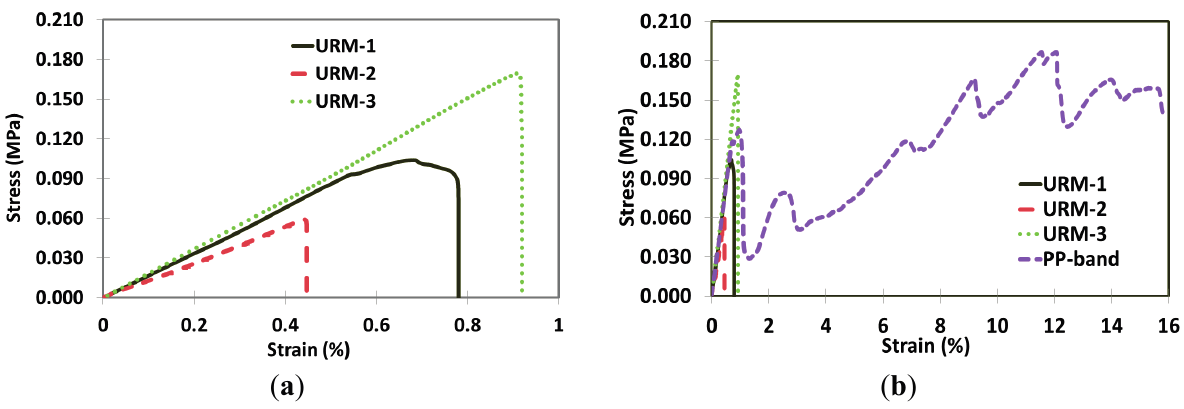
Figure 1. Stress-strain curves of masonry panels under diagonal compression test, ( a ) stress-strain curves of non-retrofitted (URM) masonry panels and ( b ) stress-strain curves of URM and PP-band retrofitted masonry panels.